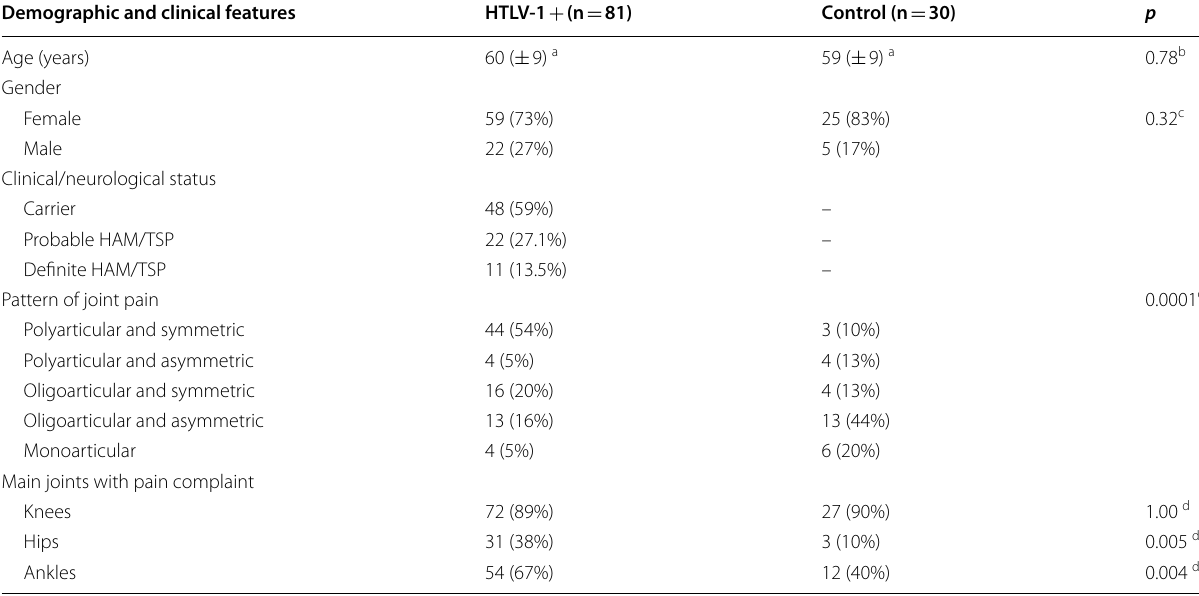
Table 1 Demographic and clinical characteristics of 81 HTLV-1-infected patients and 30 controls with osteoarthritis